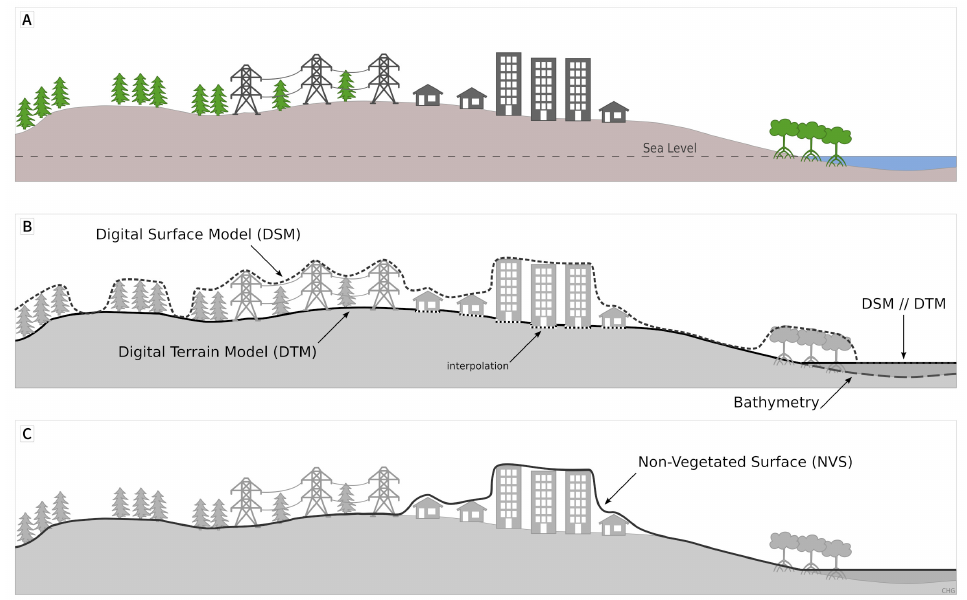
Figure 4. ( A ) Terrain being represented by a ( B ) digital surface model (DSM), and digital terrain model (DTM), and ( C ) a non-vegetated surface